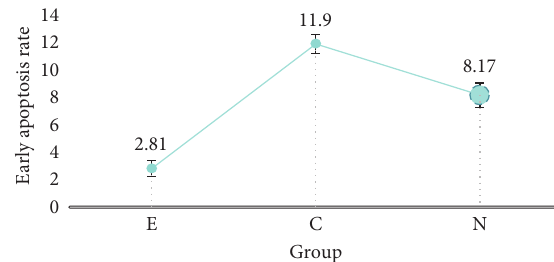
Figure 2: Early apoptosis rate of different